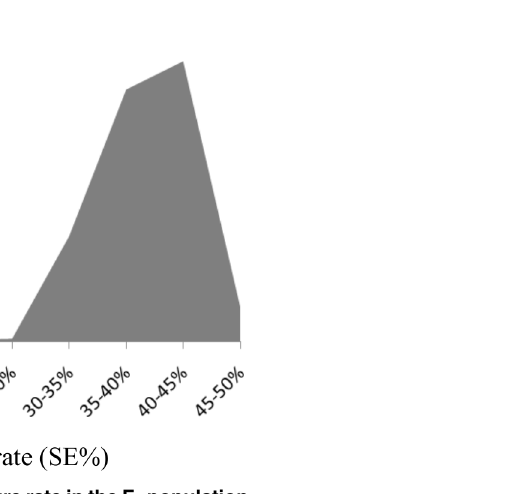
Fig 2. Distribution of the stigma exposure rate in the F 2 population.